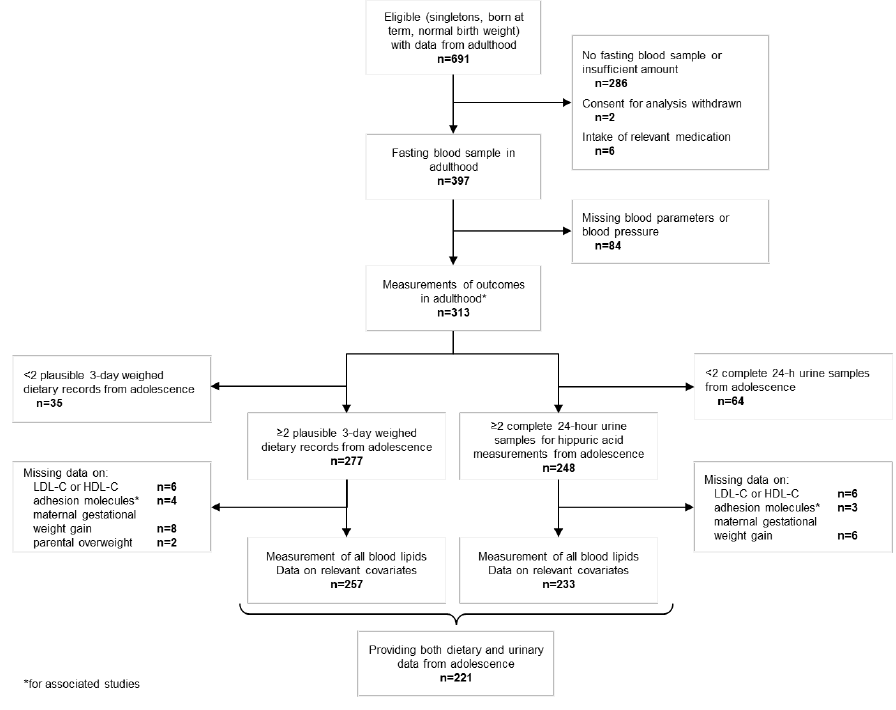
Figure 1. Participant flow diagram. HDL-C, high-density lipoprotein cholesterol; LDL-C, low-density lipoprotein cholesterol.